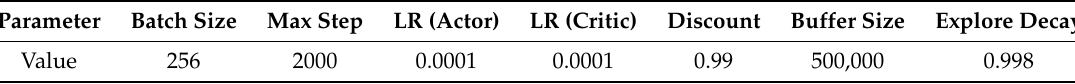
Figure 5. ( a ) the initial state of the group of mobile robots; ( b ) the terminal state of the group of mobile robots after accomplishing the formation construction navigation. Table 2. Hyperparameters of the networks on multi-robot navigation tasks.